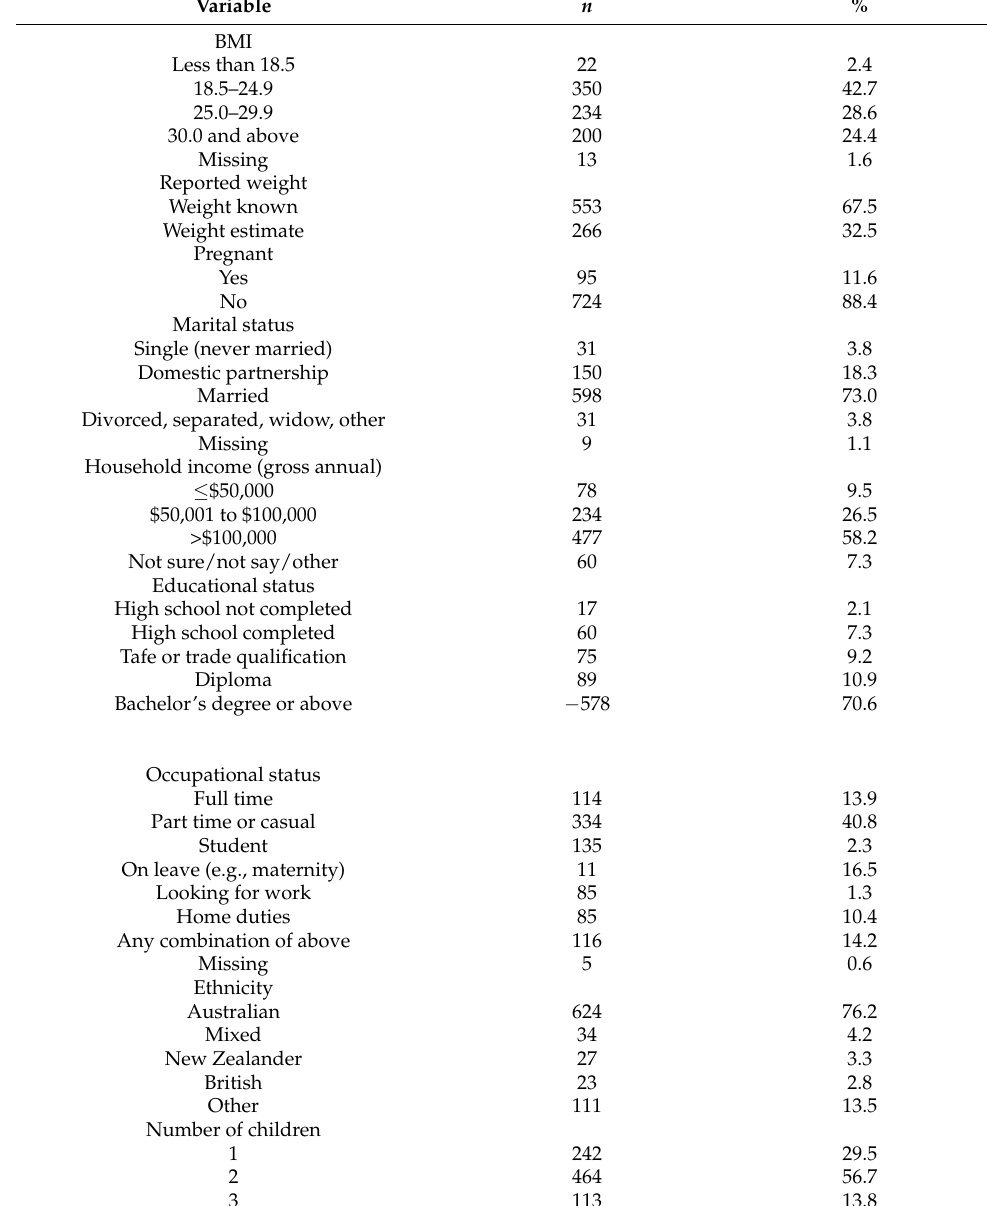
Table 1. Demographics of Participants. ( n =